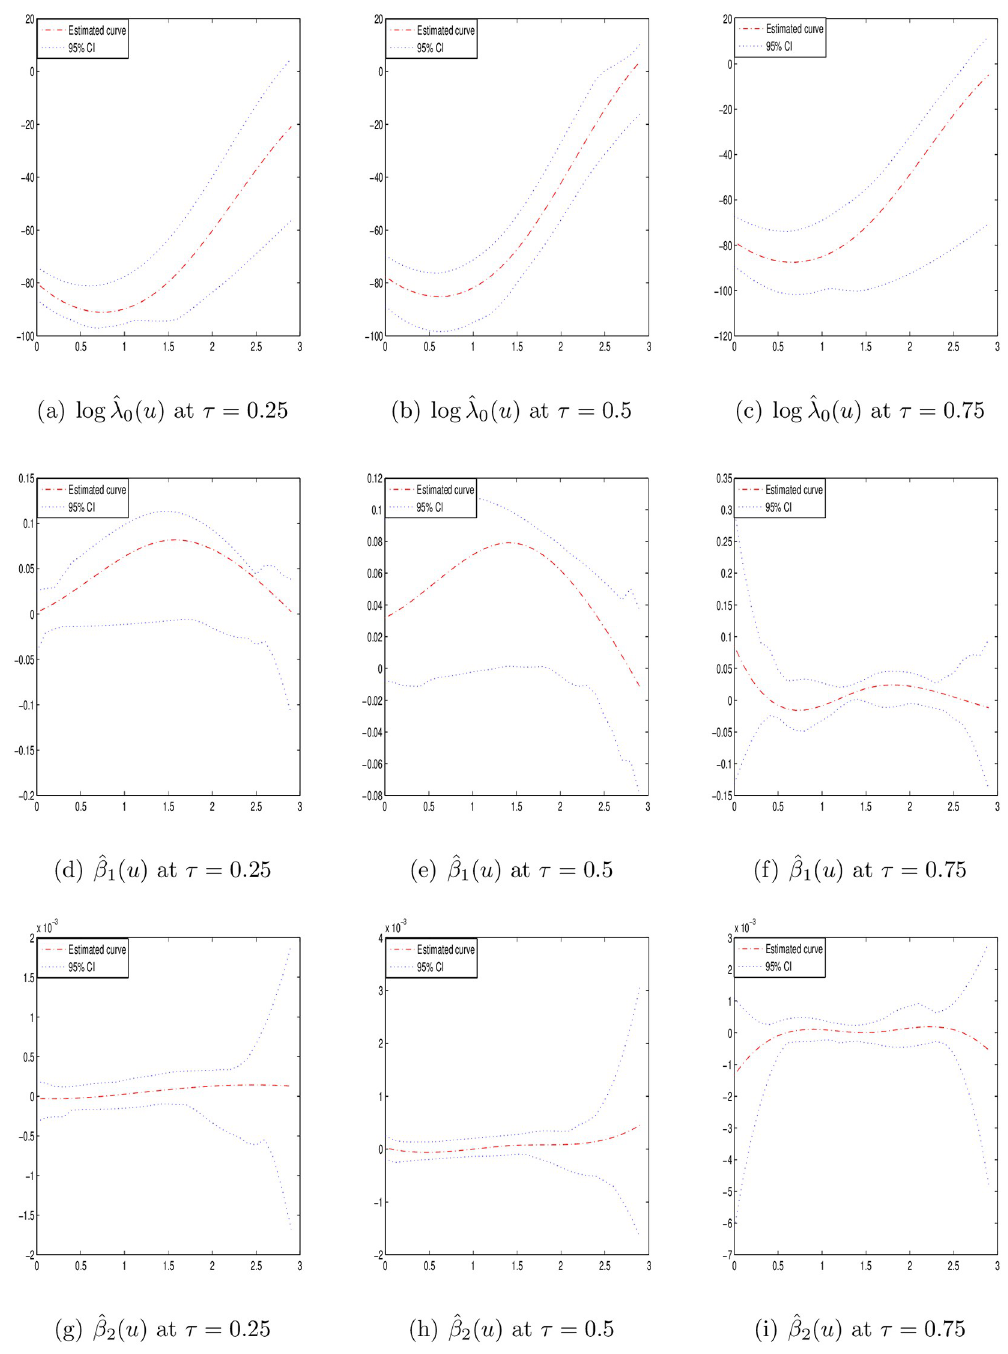
Fig 5. Estimated curves of time-varying functions for US flight delay data at different τ . The estimation curves of log λ ( t ) and β ( t ), k = 1, 2, under different quantiles τ 2 {0.25, 0.5, 0 k 0.75} are displayed in Fig 5. From Fig 5, we can find that the departure delay time is positively correlated with the cumulative flight delay numbers. Besides, the impact of the departure delay time is varying over the time under different quantiles and the impact is different at different quantiles. However, the effect of the flight distance is not significant on the flight delay numbers.